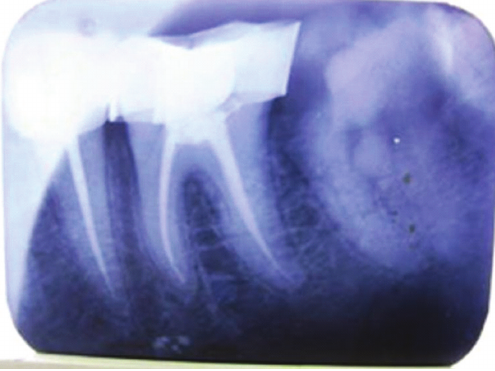
Figure 3: Postobturation